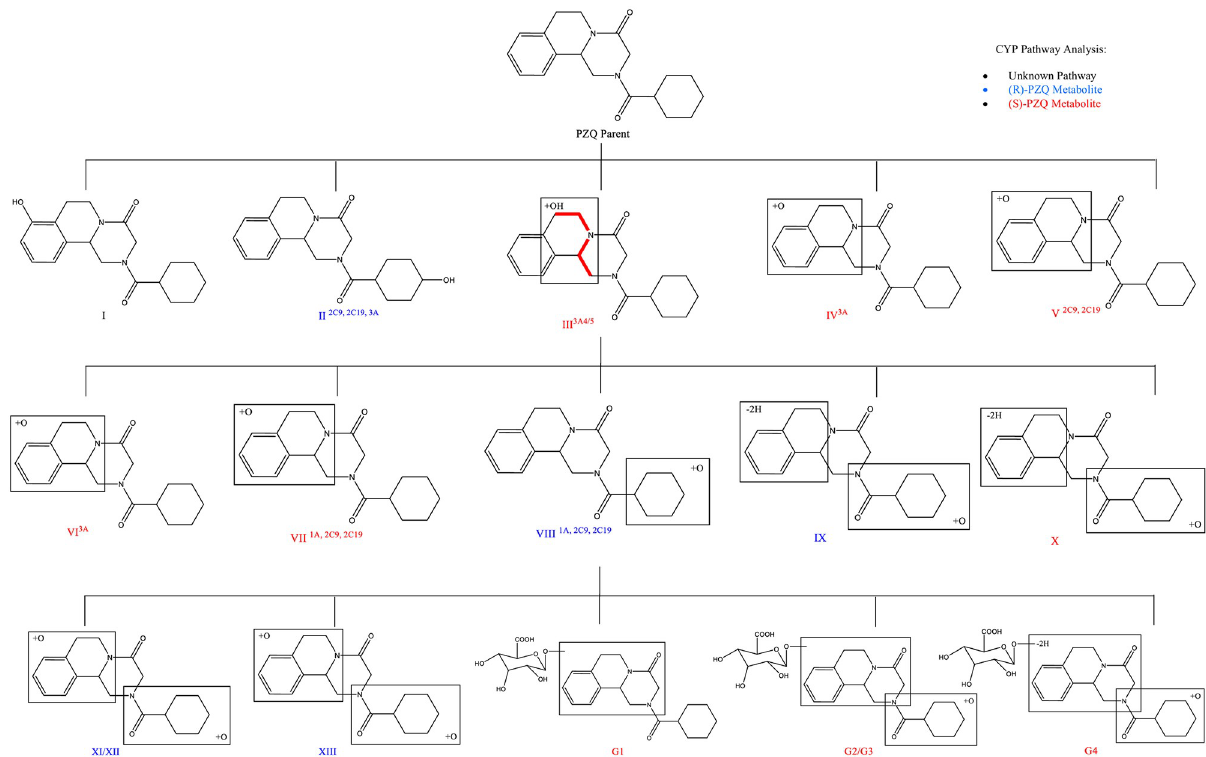
Fig 7. A comprehensive map of PZQ metabolites extracted and combined from studies that focused on the metabolite analysis of PZQ. I: 8-OH-PZQ [89], II: 4-OH-PZQ [28, 53], III: X-OH-PZQ [84], IV: O-PZQ [28], V:O-PZQ [28], VI: O-PZQ [28], VII: O-PZQ [28], VIII: O-PZQ [28], IX: (-2H)-O-PZQ [28], X: (-2H)-O-PZQ [28], XI/XII: O 2 -PZQ [28], XIII: O 2 -PZQ [28], G1: Gluc-PZQ [28], G2/G3: Gluc-O-PZQ [28], G4: (-2H)-Gluc- O-PZQ [28]. The chemical structures and metabolite map were created using ChemDraw Prime v16.0. Gluc, glucuronide; PZQ, praziquantel.